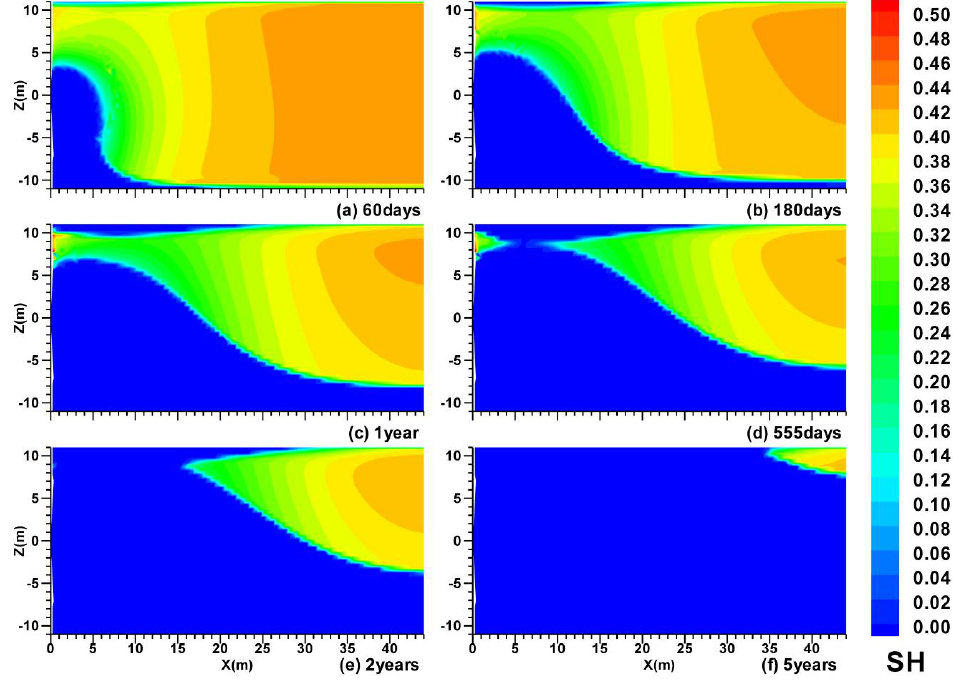
Figure 8. Evolution of spatial distribution of S in Case